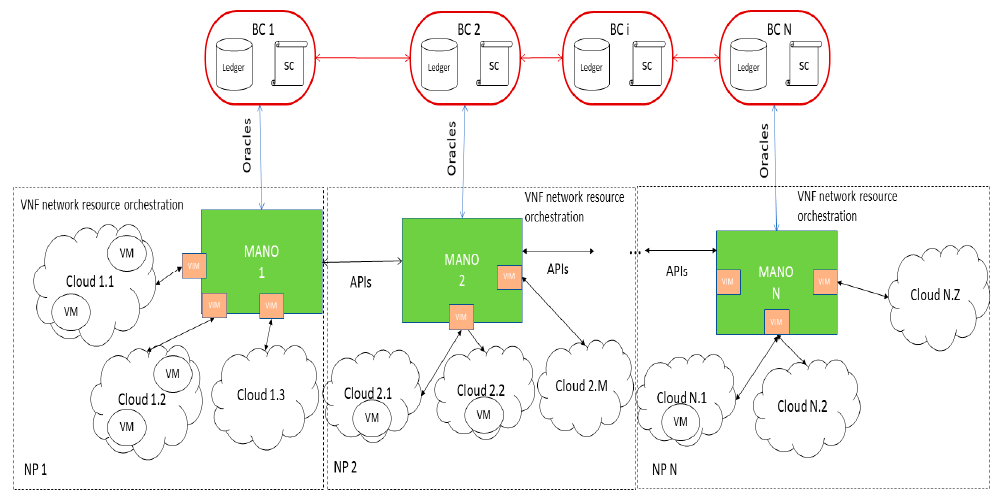
Figure 1. The proposed system architecture .